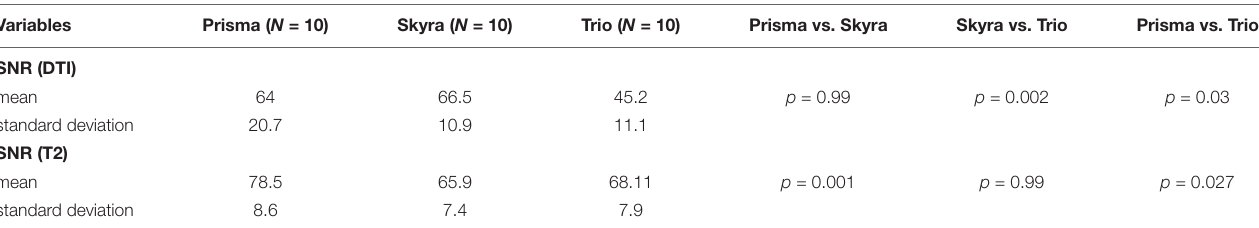
TABLE 4 | Quantitative signal-to-noise ratio (SNR) analysis for the diffusion tensor imaging (DTI) and T2 relaxometry sequence.